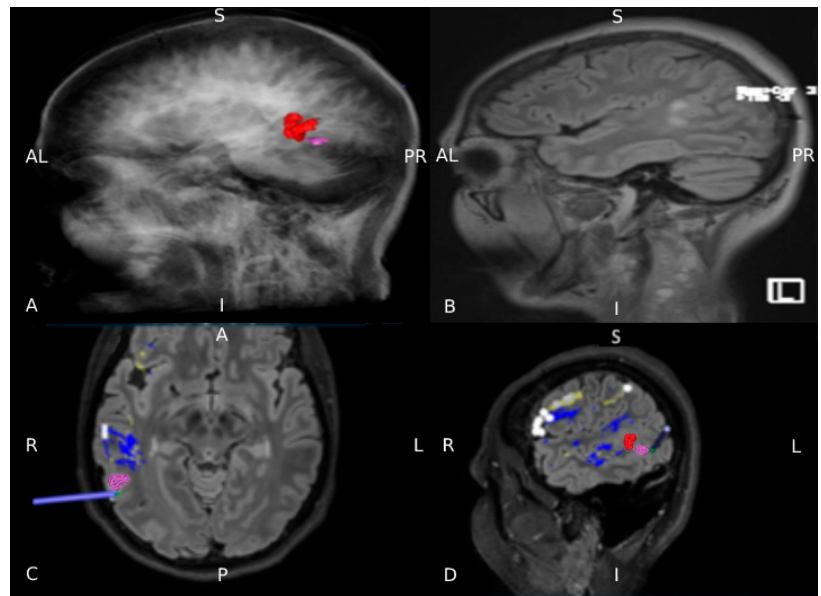
Figure 4. rnTMS-based planning using StealthViz software. ( A ) The anterior and eloquent part of the lesion identified by nTMS is colored in red and the posterior non-eloquent part in violet, ( B ) 3D FLAIR anatomical images for comparison. ( C , D ) A subtotal resection was planned and guided by neuronavigation (in violet the non-eloquent part).